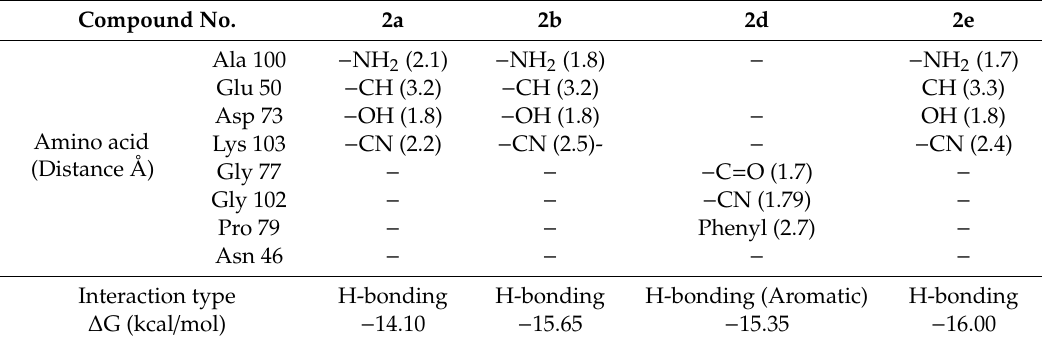
Table 8. Description of the docking data of the selected target compounds, 2a , 2b , 2d , and 2e inside the active site of the gyrase B (Protein Data Bank (PDB) ID: 4PRV).